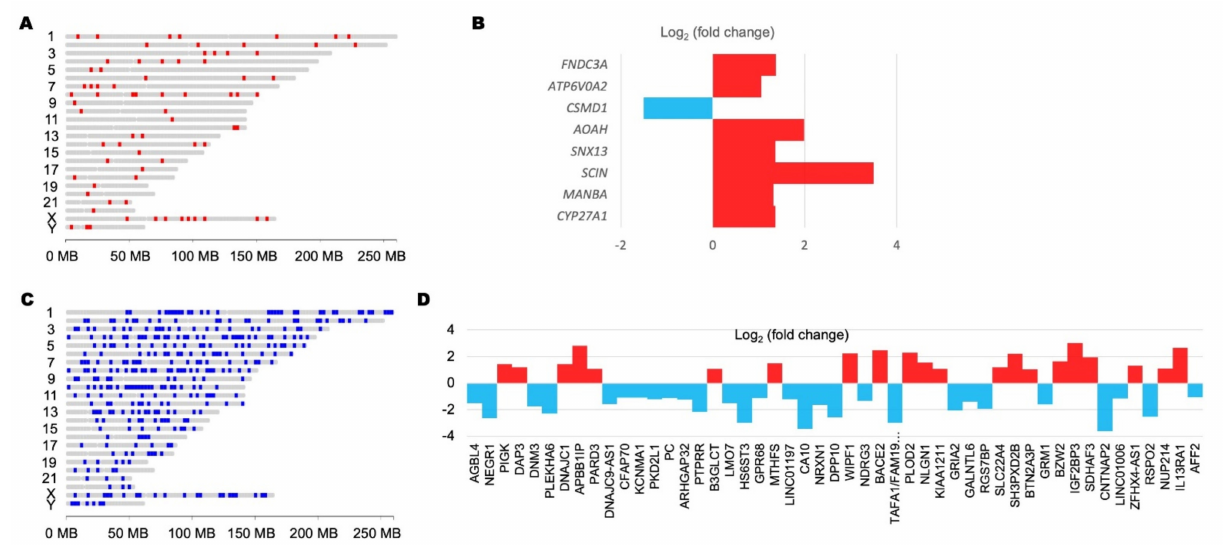
Figure 3. Differential expression of human endogenous retroviruses (HERVs) and the surrounding genes in GBM. ( A ) Chro- mosomal plot of the genomic distribution of the differentially expressed LTR21A_LTR_ERV1. ( B ) Differentially expressed genes within 1 kilobase of differentially expressed LTR21A_LTR_ERV1. ( C ) The location of the differentially expressed MER11B_LTR_ERVK plotted on chromosomes. ( D ) Differentially expressed genes within 1 kilobase of differentially expressed MER11B_LTR_ERVK.